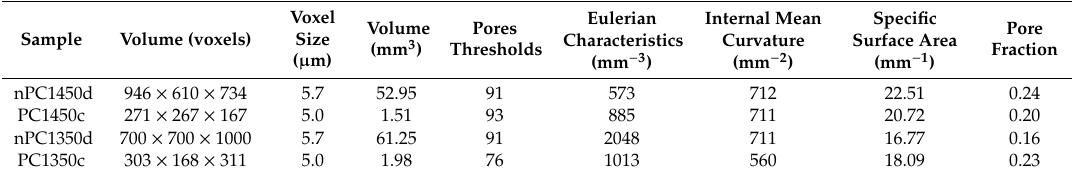
Table 2. Results obtained by applying the Basic Analysis module of the Pore3D software library extracted from the laboratory X-ray µ CT data.